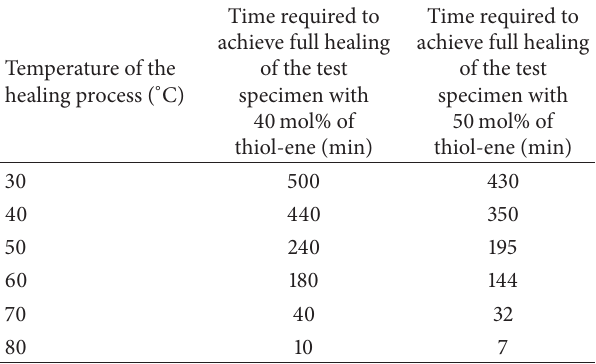
Table 2: Healing times for the test specimens with 40% mol and 50 mol% of the thiol-ene